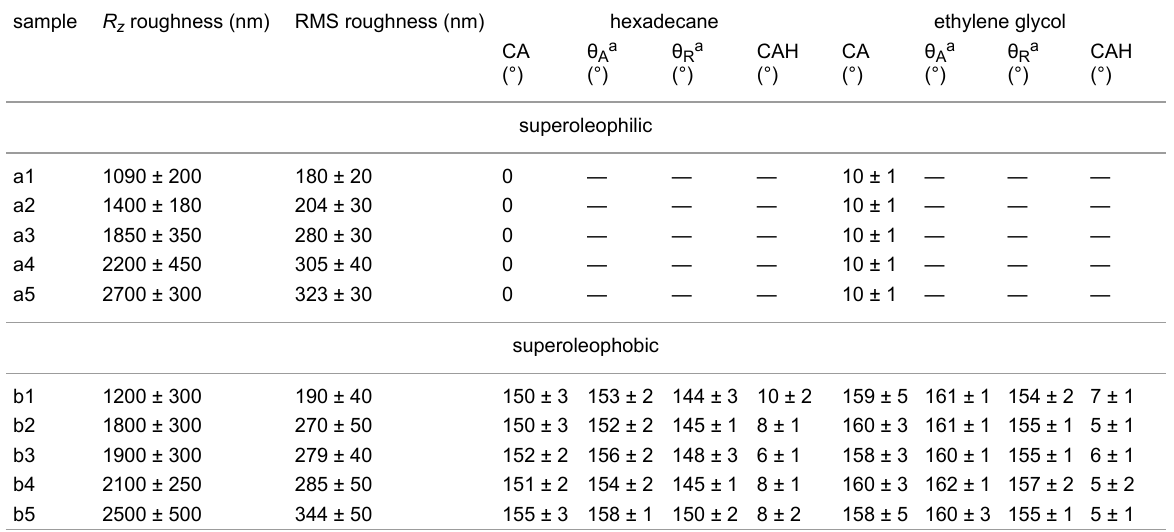
Table 3: R z and RMS roughness, and CA and CAH of the superoleophilic and superoleophobic surfaces. sample R z roughness